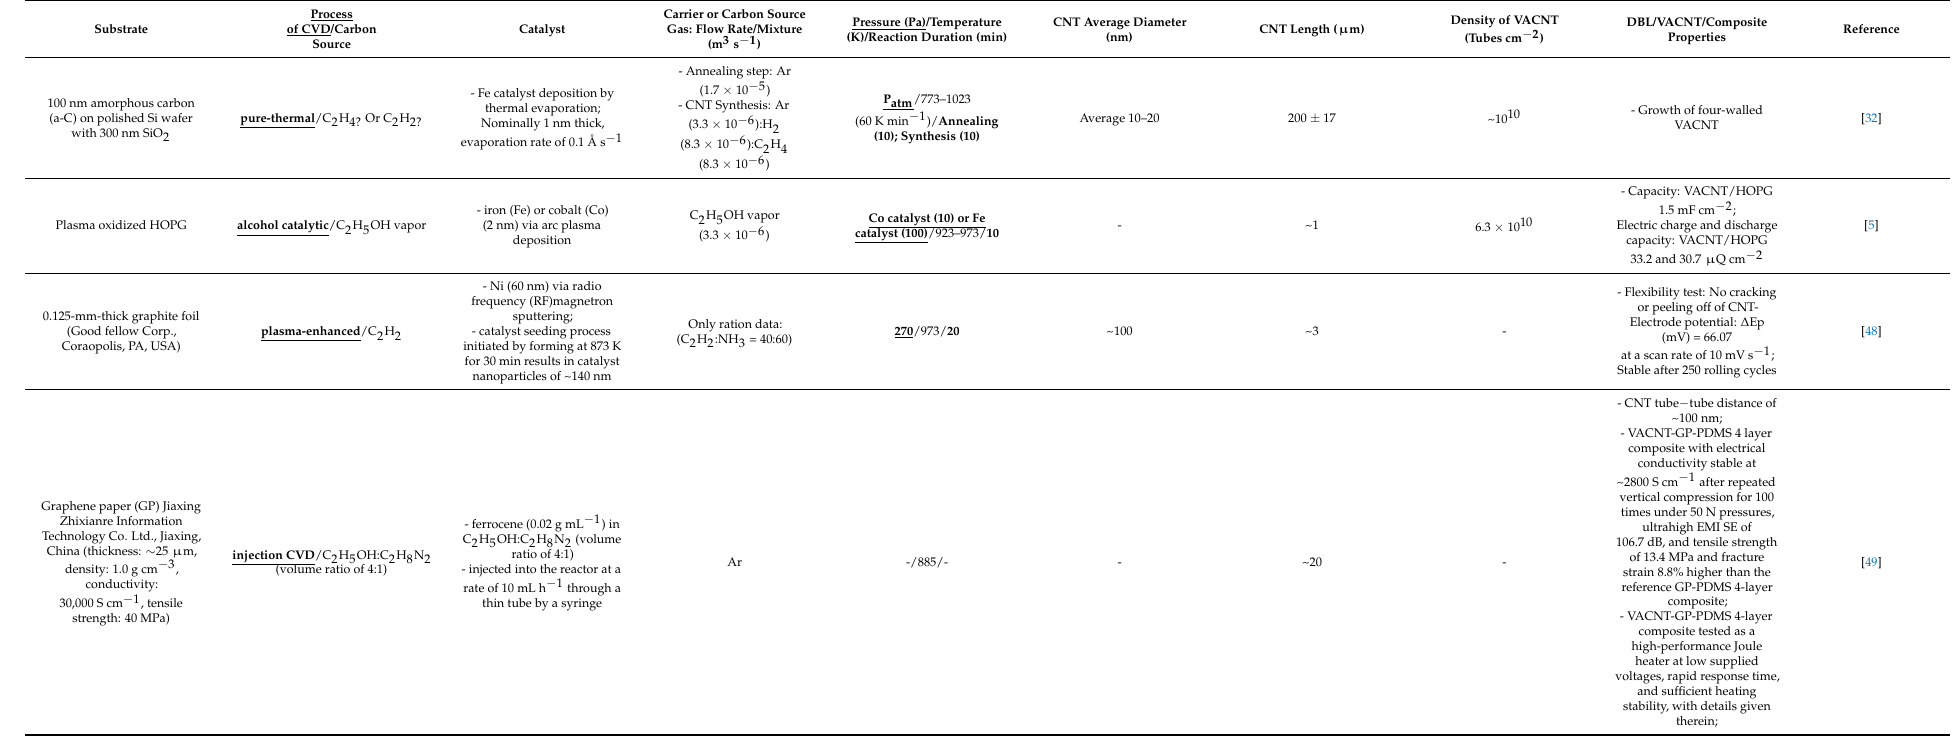
Table 7. Details of used carbonaceous substrates for direct growth of